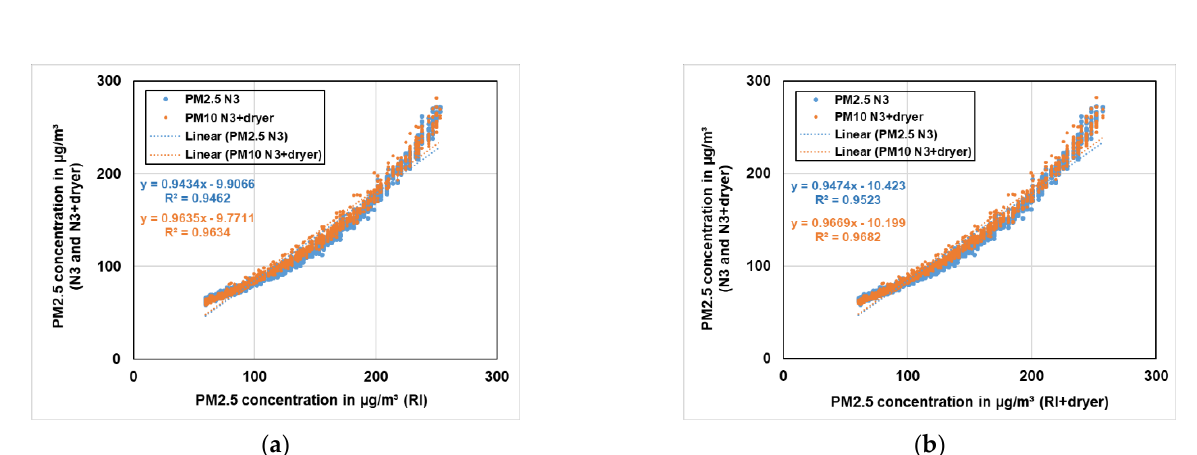
Figure 19. ( a ) Comparison of PM2.5 concentration of RI to the PM2.5 concentration of both low-cost PM sensors (N3 and N3+dryer) with the same dryer settings. ( b ) Comparison of PM2.5 concentration of RI+dryer to the PM2.5 concentration of both low-cost PM sensors (N3 and N3+dryer) with the same dryer settings.